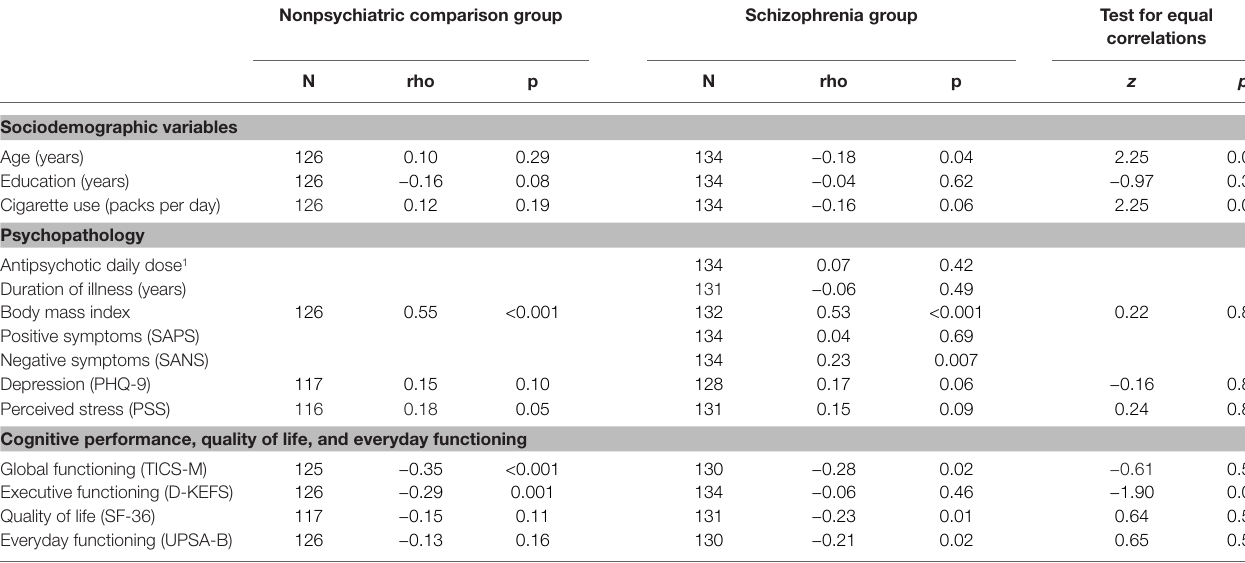
TABLE 2 | Spearman’s correlations of insulin resistance (HOMA-IR) in participants with and without schizophrenia. Nonpsychiatric comparison